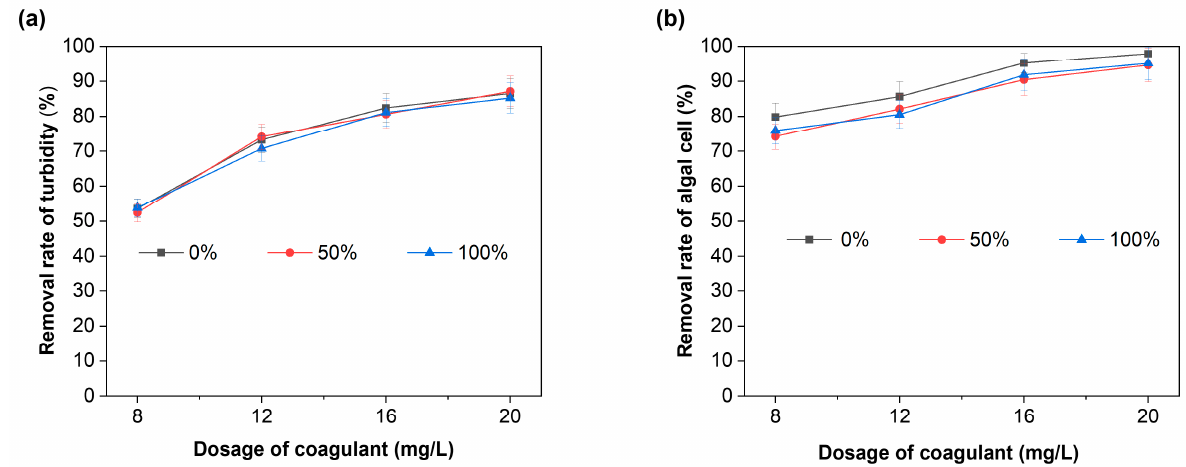
Figure 6. Impact of filler on turbidity removal rates ( a ) and algal cell removal rates ( b ).